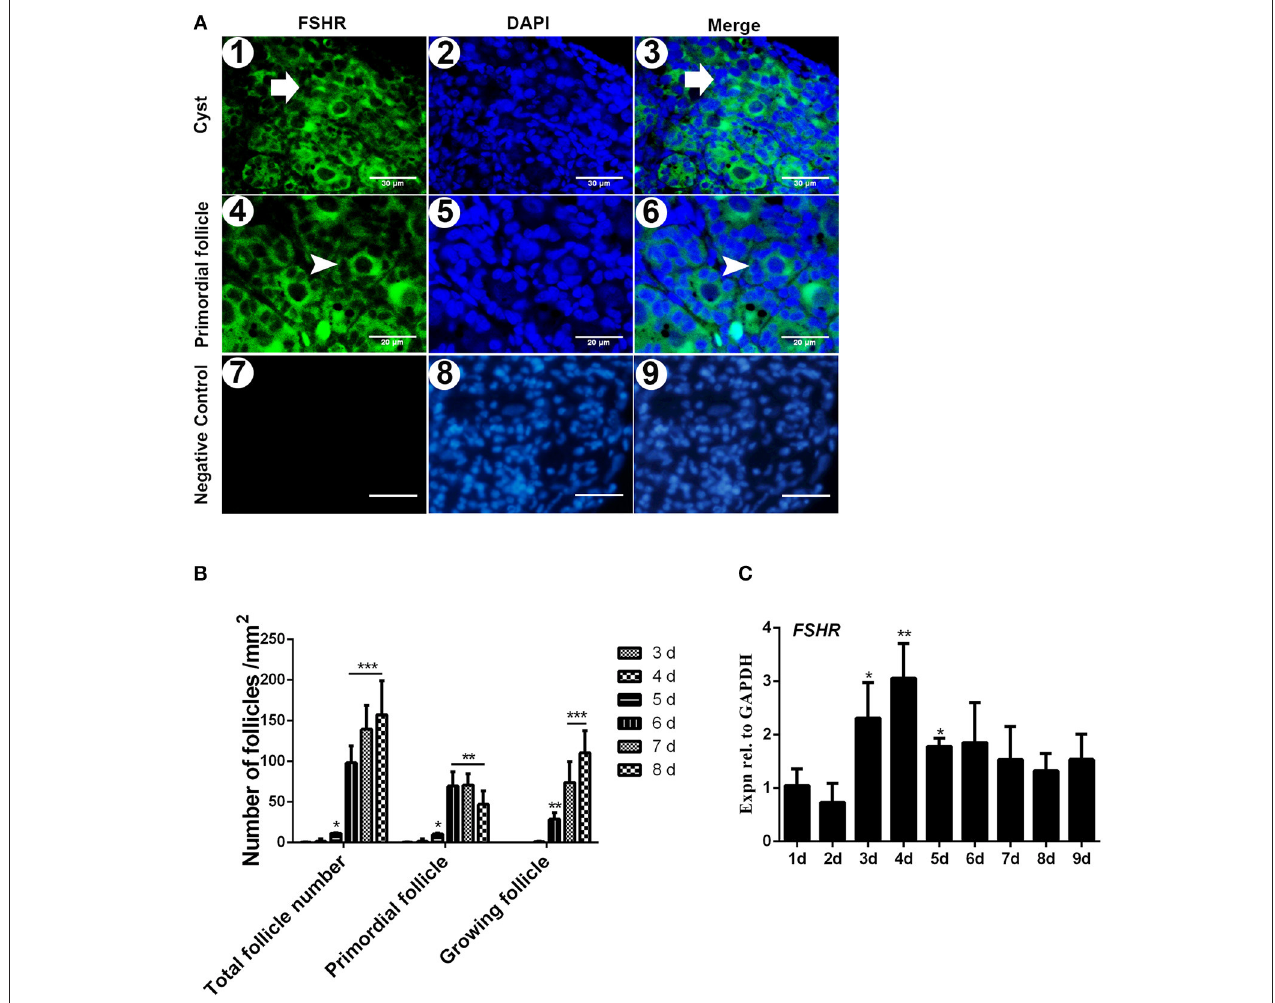
FIGURE 1 | Expression of FSHR mRNA increased significantly on the initial formation of chicken primordial follicles. (A) Cellular localization of FSHR in 6-day-old chicken ovaries. FSHR (green) existed in both the cysts (arrows in 1–3) and primordial follicles (arrowheads in 4 and 6). Scale bars (1–3): 30 µ m. Scale bar (4–6): 20 µ m. Negative control scale bars (7–9): 30 µ m. DAPI (blue, 2 and 5) was used to identify the nuclear DNA. (B) Changes of total, primordial, and growing follicle number from Day 3 to 8. (C) FSHR mRNA expression was measured by qRT-PCR in ovaries from the first to 9th day in the chickens. GAPDH was used as a normalization control. T -tests were used to determine statistically significant differences. The values are the mean ± SEM of six experiments. Asterisks indicate significant differences (* P < 0.05, ** P < 0.01, *** P < 0.001).